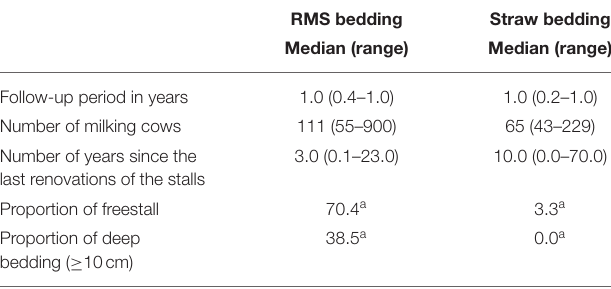
TABLE 1 | Description of the 26 recycled manure solids farms and 60 straw farms. RMS